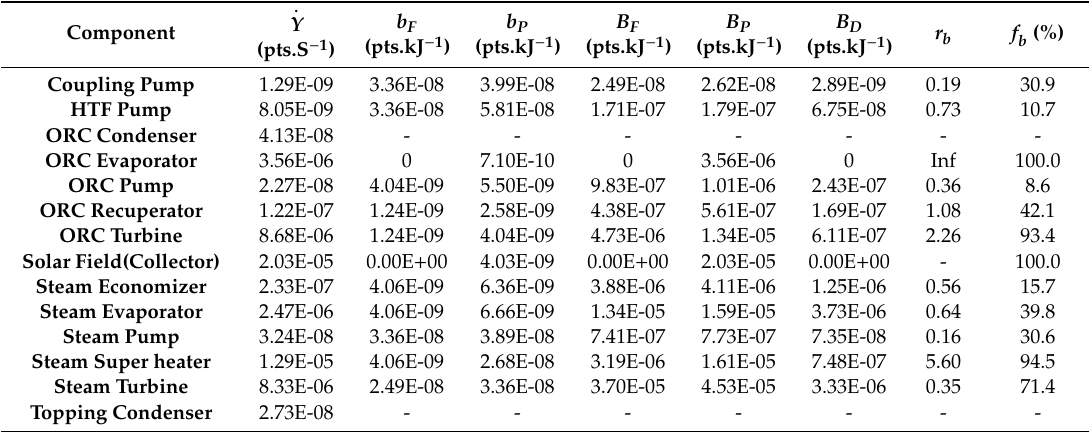
Table 12. Exergo-environmental calculations in the solar–geothermal cycle (SGPP).